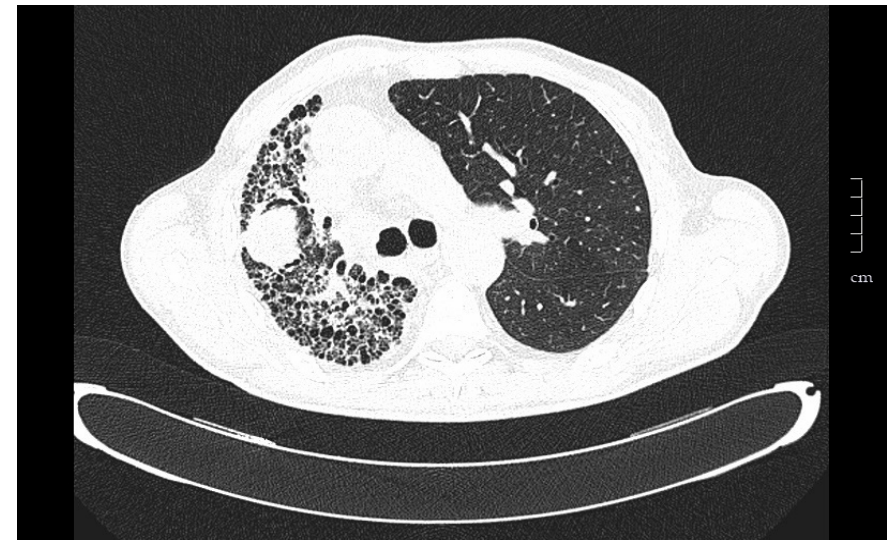
Figure 1. Tomography of a 67-year-old man that underwent left unilateral lung transplantation for pulmonary fibrosis. The native lung tends to collapse, and the graft expands freely. Eight years after transplantation a tumor in the native lung was found in a follow-up chest scan. Ultrasound-guided fine needle aspiration puncture diagnosis was squamous cell carcinoma.